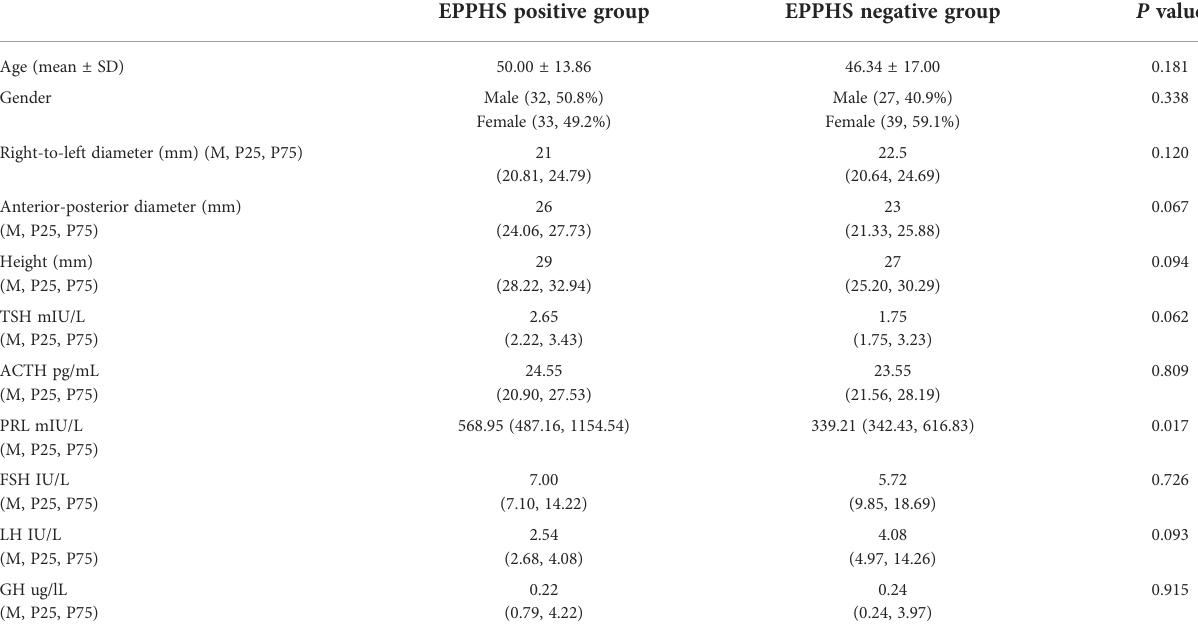
TABLE 2 Comparison of indicators of EPPHS negative and positive